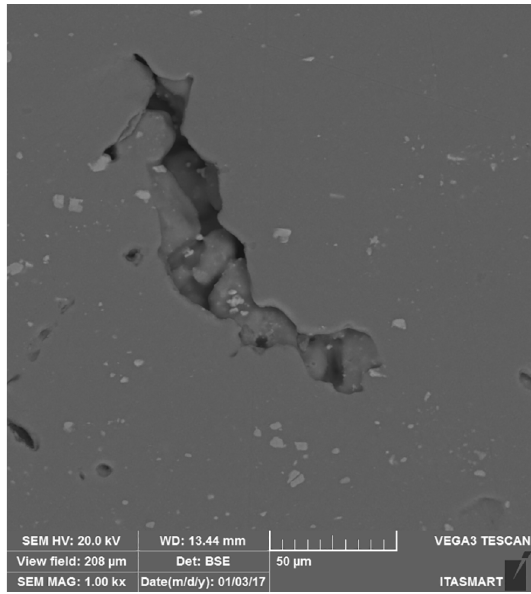
Figure 16. SEM images of domes processed without back-pressure showing the grains inside a void, samples extracted from the positions of (φ=45º; θ=0º). The rolling plane is parallel to the page and the rolling direction is horizontal to the